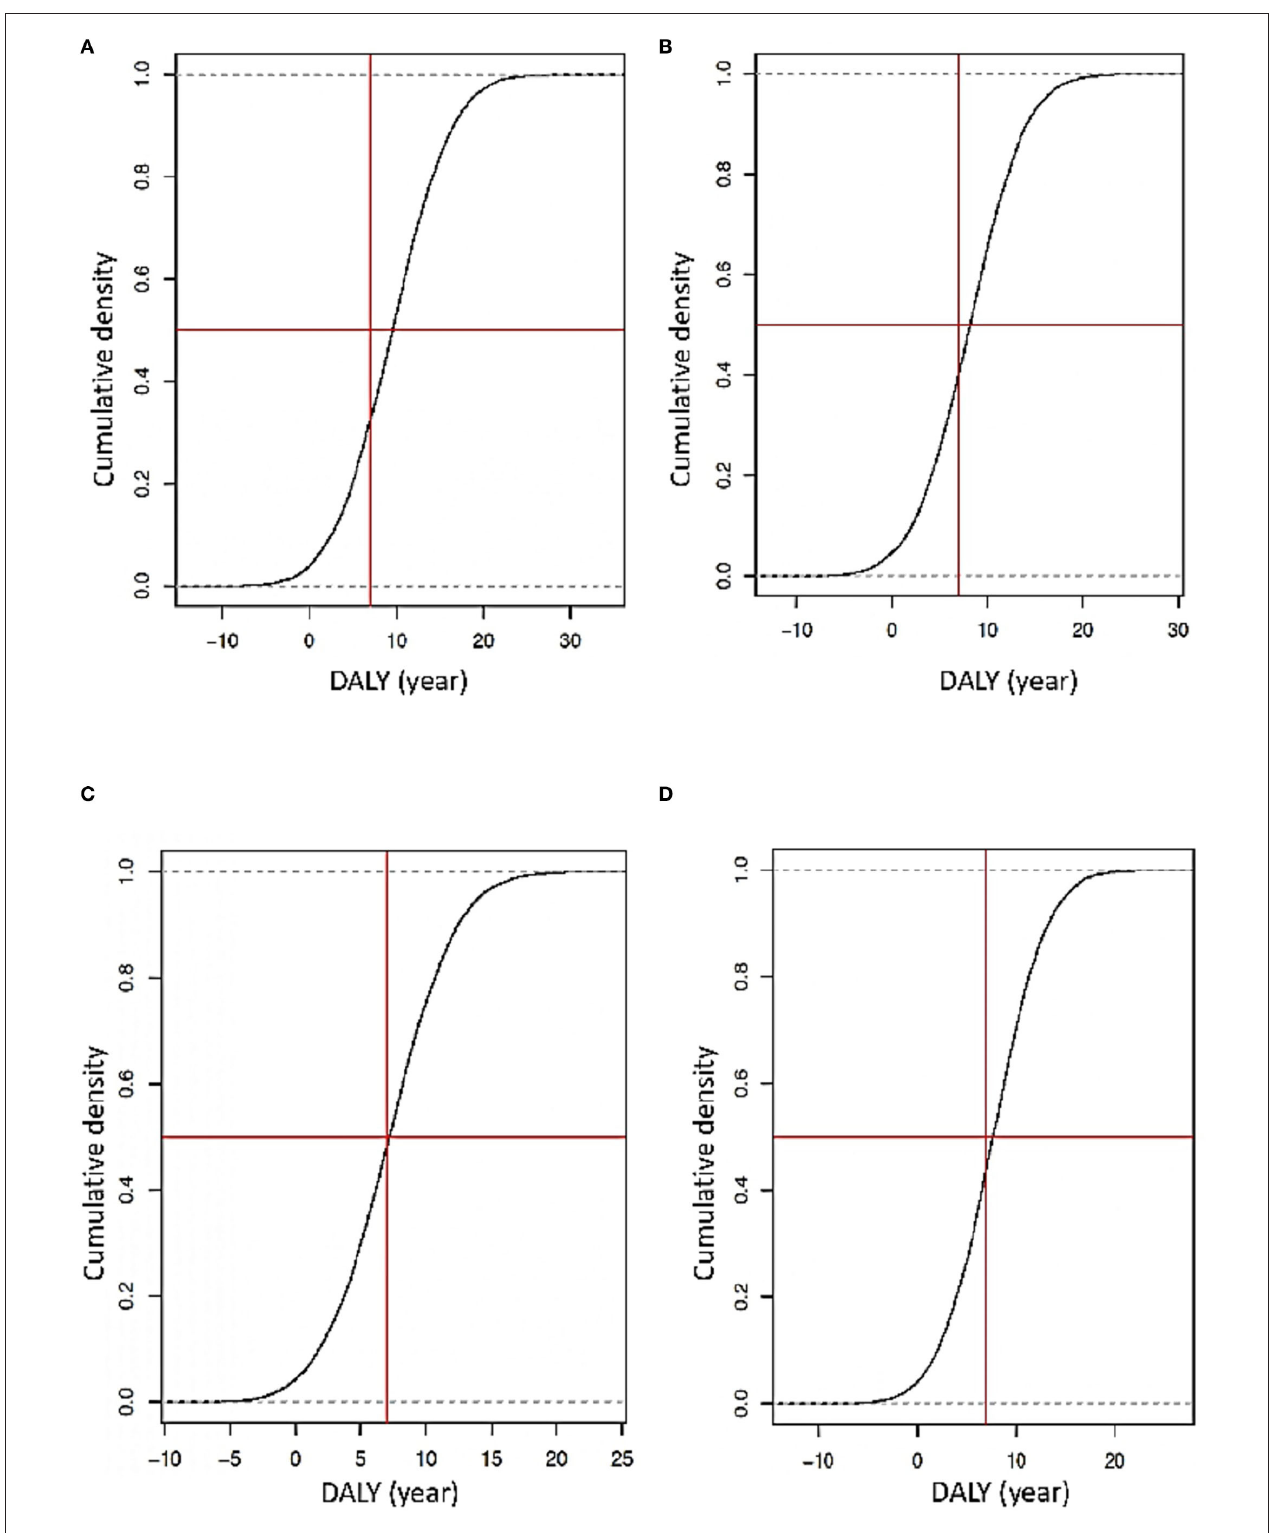
FIGURE 8 | (A) Simulation of DALY’s years’ loss or gain using deterministic data for the exclusive use of ART. (B) Simulations of DALY’s years gained or loss using stochastic data for ART use alone. (C) Simulations of DALY’s years gained or loss using deterministic data for PrEP like prevention. (D) Simulations of DALY’s years gained or loss using stochastic data for PrEP like prevention (the Y-axis is the probability of loss or gain years of life due to an implemented strategy. The vertical red line represents the standard DALYs lost by a later diagnosis, and the horizontal red line is the logistic regression threshold of 50%).